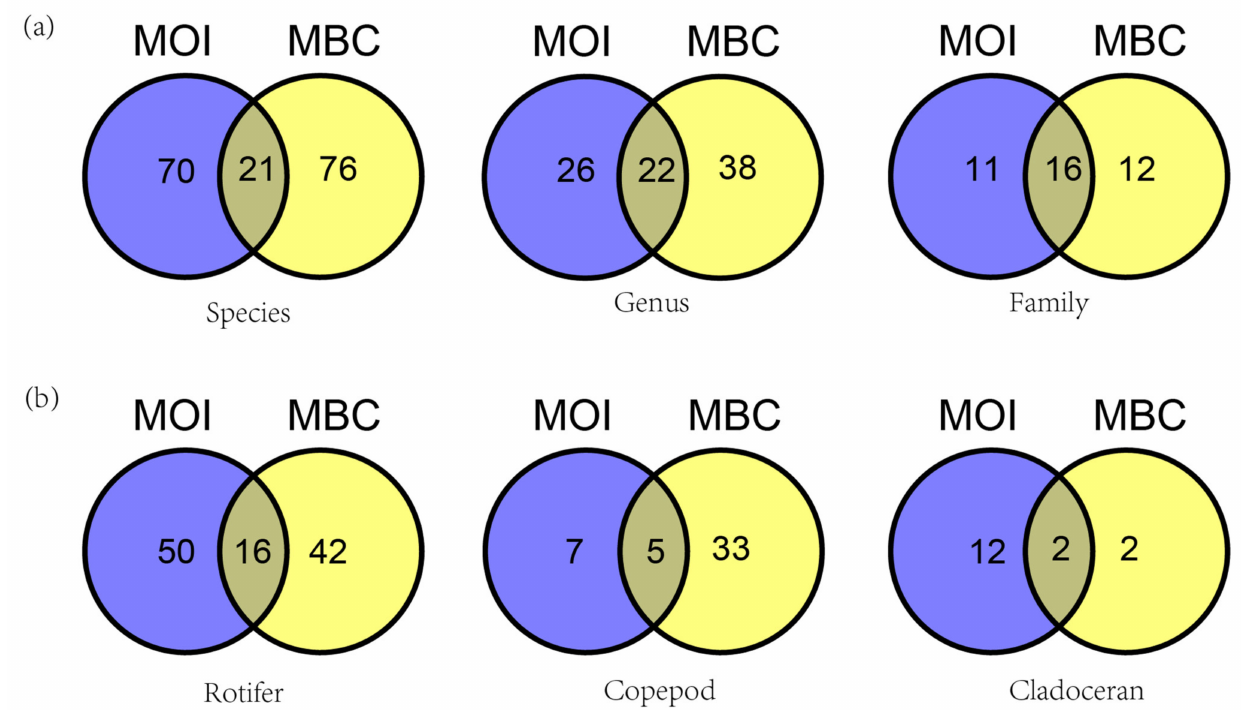
Figure 4. Venn diagram comparing the assessment of species composition in Shahu Lake (China). ( a ) Venn diagrams of zooplankton composition at the species, genus, and family level by MOI and MBC. ( b ) Venn diagrams of species composition of Rotifer, Copepod, and Cladoceran by MOI and